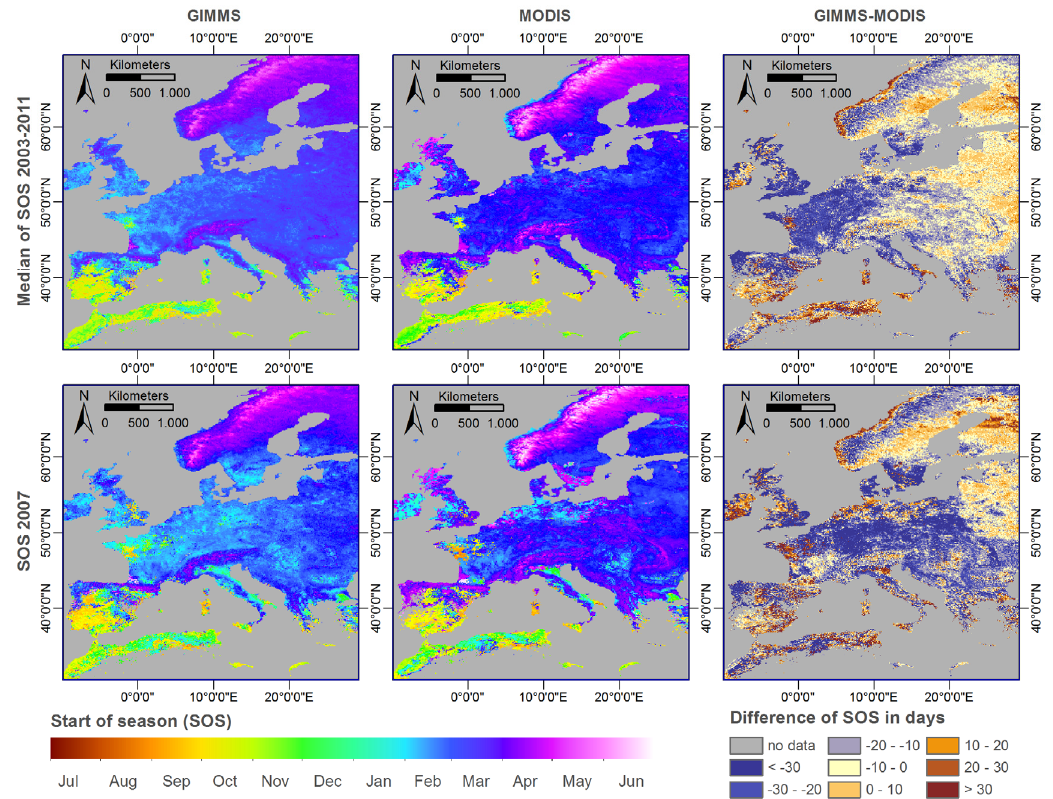
The disagreement between the two time series is further sustained when plotting the SOS of both time series against each other (Figure 13). The regression analysis between the two SOS data sets reveals